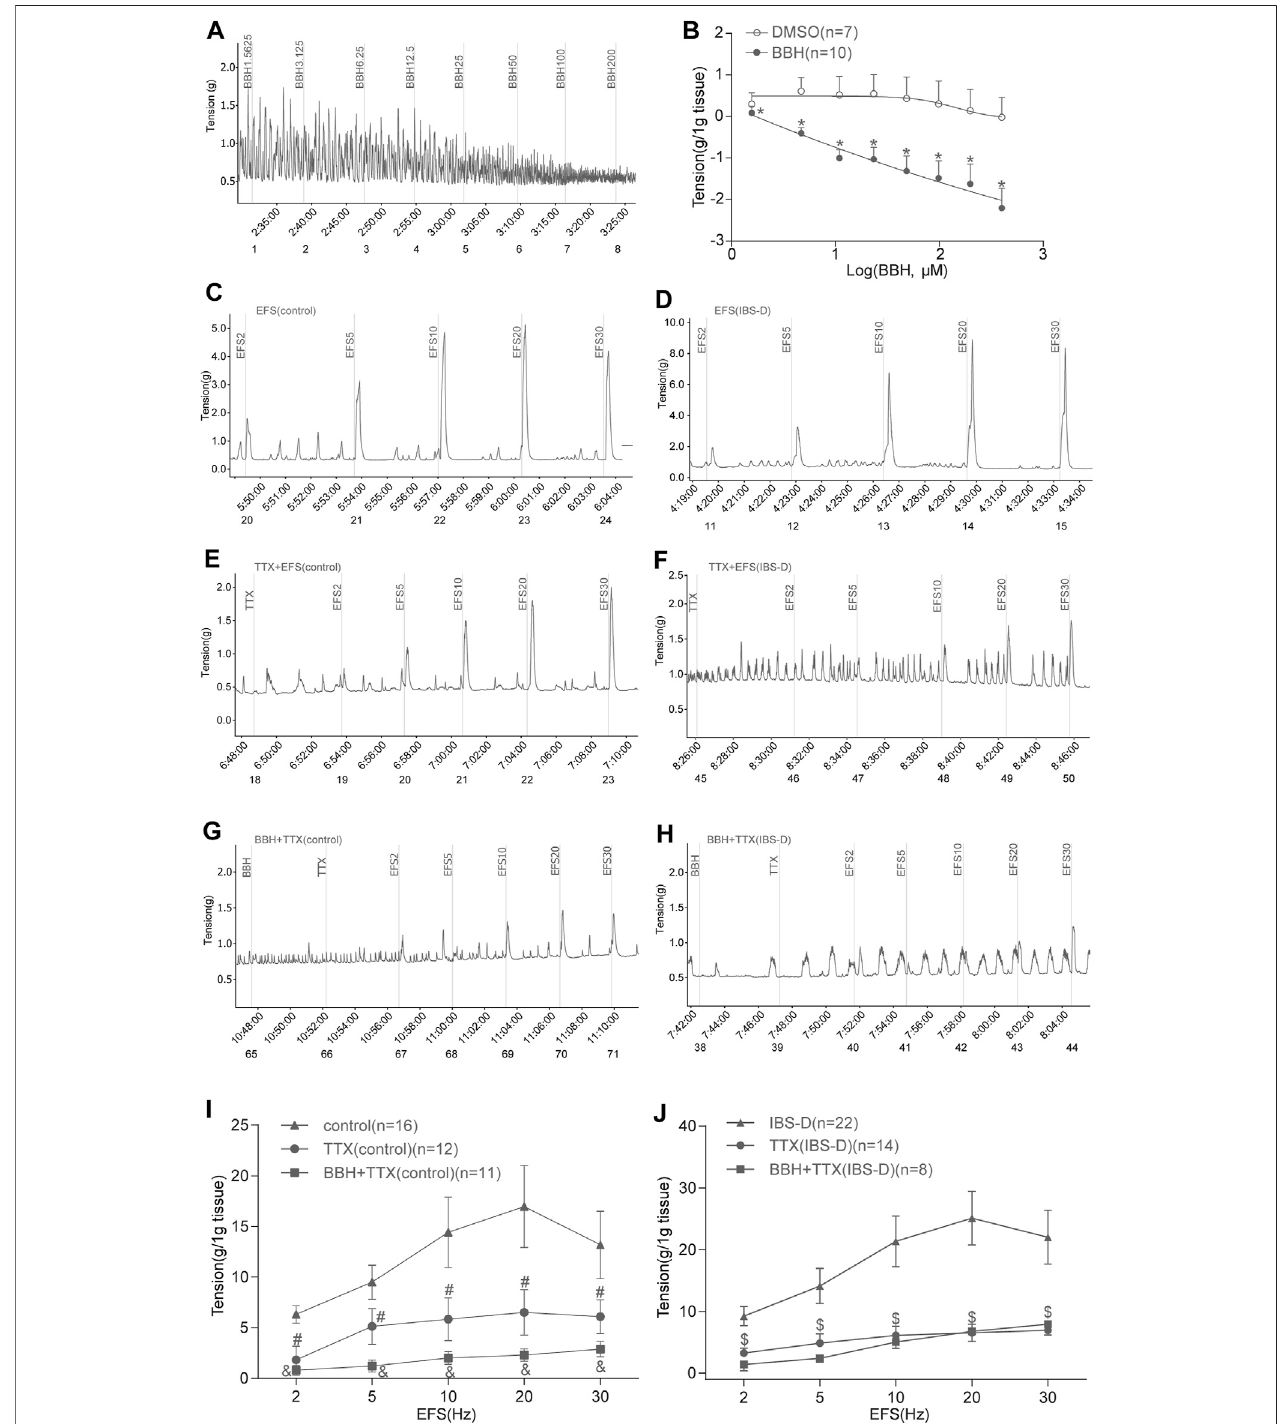
FIGURE 5 | BBH inhibited spontaneous and EFS-induced contractions of TTX-treated isolated colonic longitudinal smooth muscle. (A,B) Mechanical recording and linear regressioncurveofthecumulativelogconcentration – responseoftheeffectofBBH(1.5625 – 200 μ molL − 1 )onthespontaneouscontractionsoftheisolatedcoloniclongitudinalsmooth muscle.TheEC 50 ofBBHwas25.17 μ mol/L.DMSOhadnoeffect.*denotes p < 0.01comparedwiththevehicleDMSOgroup.BBH: n (cid:2) 10,DMSO: n (cid:2) 7. (C – J) Mechanicalrecording (C – H) andhistogram (I – J) oftheeffectofTTXandBBH+TTXtreatmentsontheEFS-inducedcontractionresponseofcoloniclongitudinalsmoothmuscleinthecontrolandIBS-D groups. (C) :EFS-inducedcontrolgroup( n (cid:2) 16). (D) :EFS-inducedIBS-Dgroup( n (cid:2) 22). (E) :TTX-treatedcontrolgroup( n (cid:2) 12). (F) :TTX-treatedmodelgroup( n (cid:2) 14). (G) :BBH+TTX- treatedcontrolgroup( n (cid:2) 11). (H) :BBH+TTX-treatedIBS-Dgroup( n (cid:2) 8). (I) :BBHinhibitedEFS-inducedcontractionsofTTX-treatedcolonictissuesinthecontrolgroup.#denotes p < 0.05comparedwiththeEFS-inducedcontrolgroup&denotes p < 0.05comparedwiththeTTX-treatedcontrolgroup. (J) :BBHinhibitedtheEFS-inducedcontractionsofTTX-treated colonic tissues in the IBS-D group. $ denotes p > 0.05 compared with the EFS-induced IBS-D group. Error bars represent mean ± SEM.